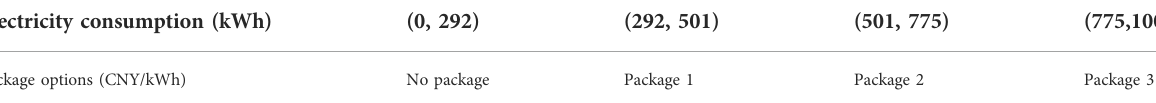
TABLE 4 Choosing from different packages on the basis of users ’ average monthly electricity